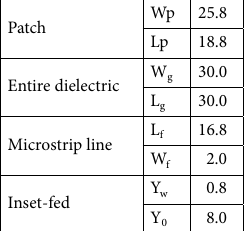
Table 3. Dimensions of the antenna, microstrip line and inset fed (in mm).